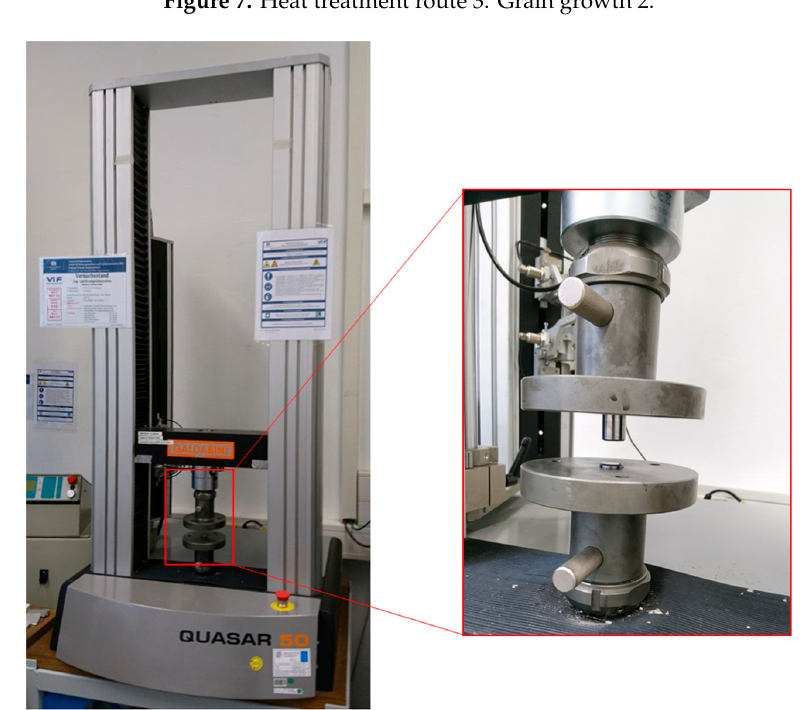
Figure 7. Heat treatment route 3. Grain growth 2.